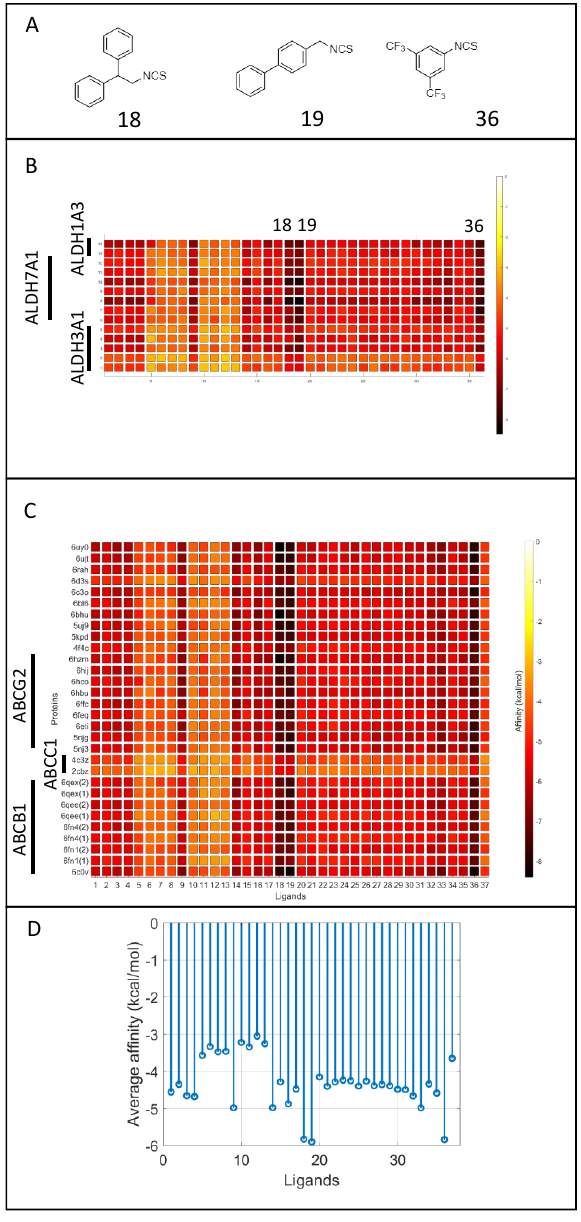
Figure 3. Molecular modeling of isothiocyanate (ICT) affinity to the tested ALDH and ABC proteins. ( A ) Chemical structures of three chosen ICTs: 18 , 19 , and 36 . ( B ) ICT affinity to the models of ALDH isoforms and ( C ) ABC proteins obtained from RCSB Protein Data Bank. ( D ) Average affinity of ICTs to all selected proteins, calculated as average of all affinity value to all structural models of each protein.